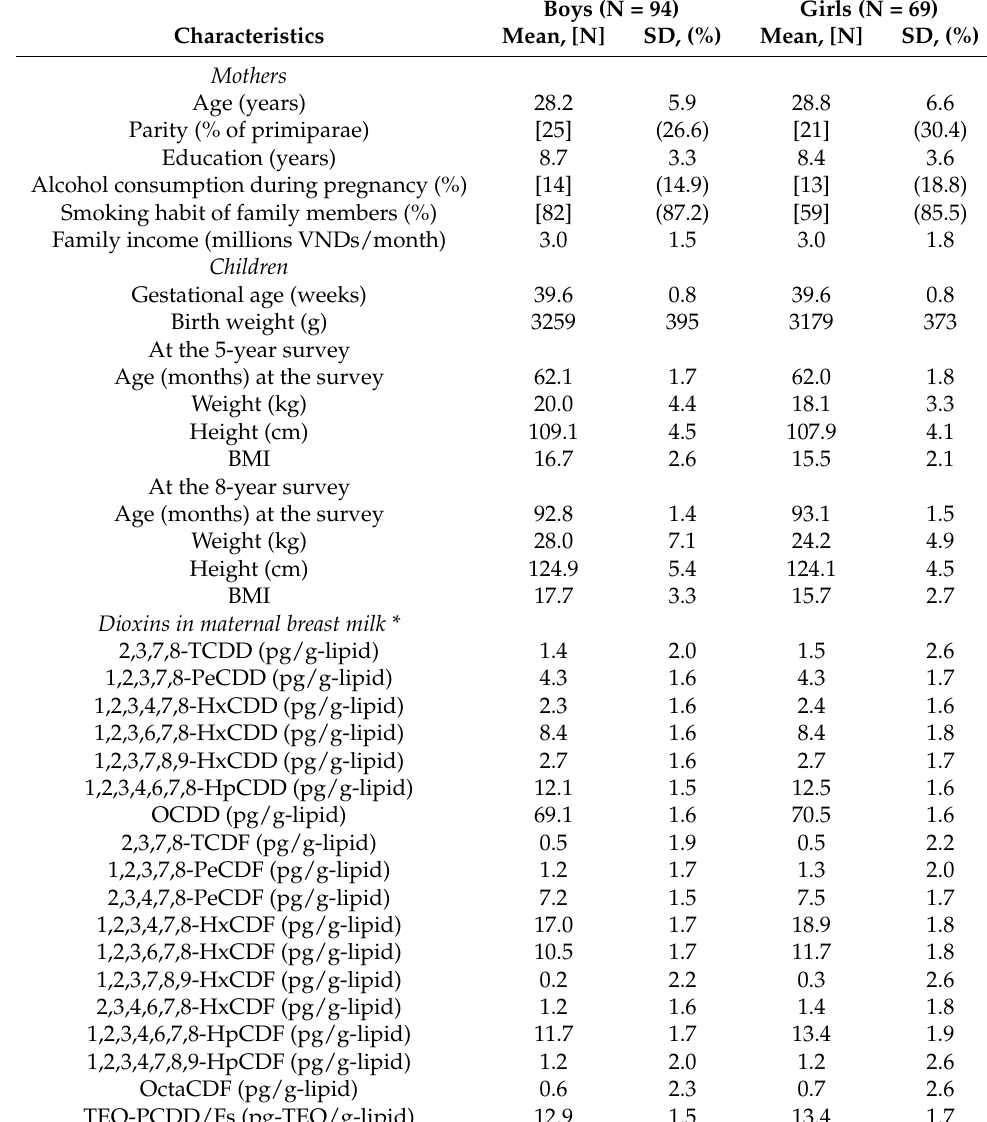
Table 1. Characteristics of the subjects and dioxin exposure in maternal breast